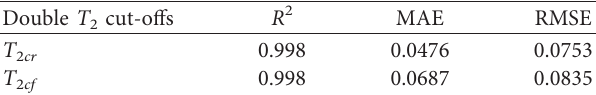
2 cut-offs: (a) T 2 cr and (b) T 2 cf . Table 6: The R 2 , MAE, and RMSE values of the predictive equations for the double T 2